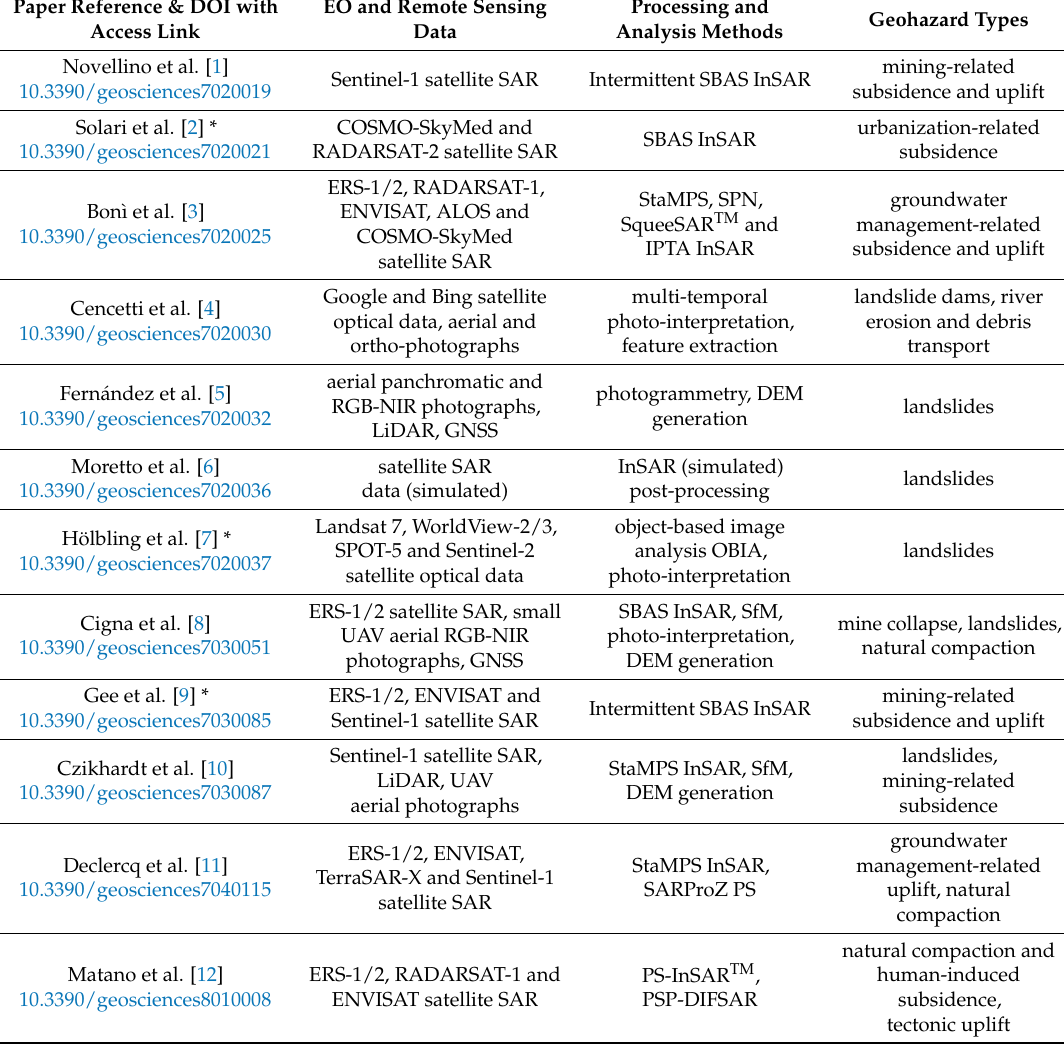
Table 1. Overview of Earth Observation (EO) data, methods, and geohazard types that are discussed in the 12 open access research papers composing the Special Issue “Observing Geohazards from Space” of Geosciences . Access links to each paper are also provided via their unique DOI numbers. Papers are sorted in ascending order according to their publication